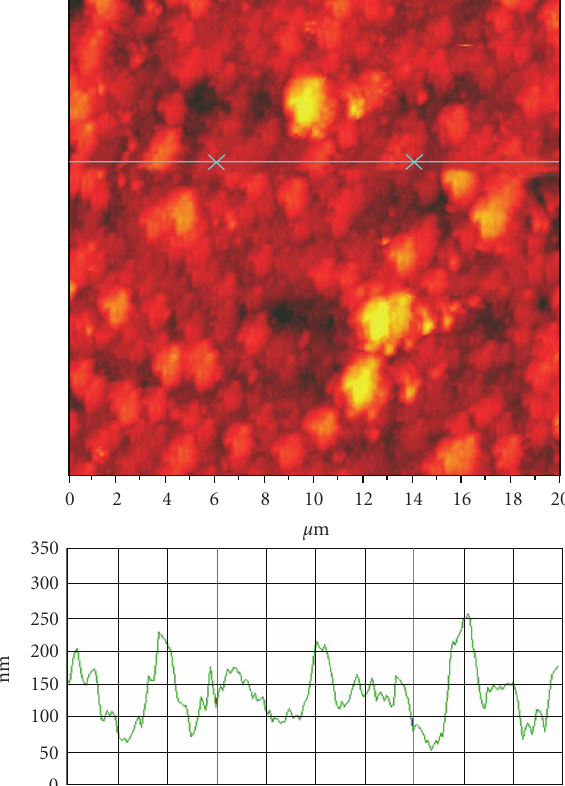
Figure 7: An AFM image of a 16 PDMS-1/PDMS-2 bilayered film prepared from water solutions. Z scale was in nm.